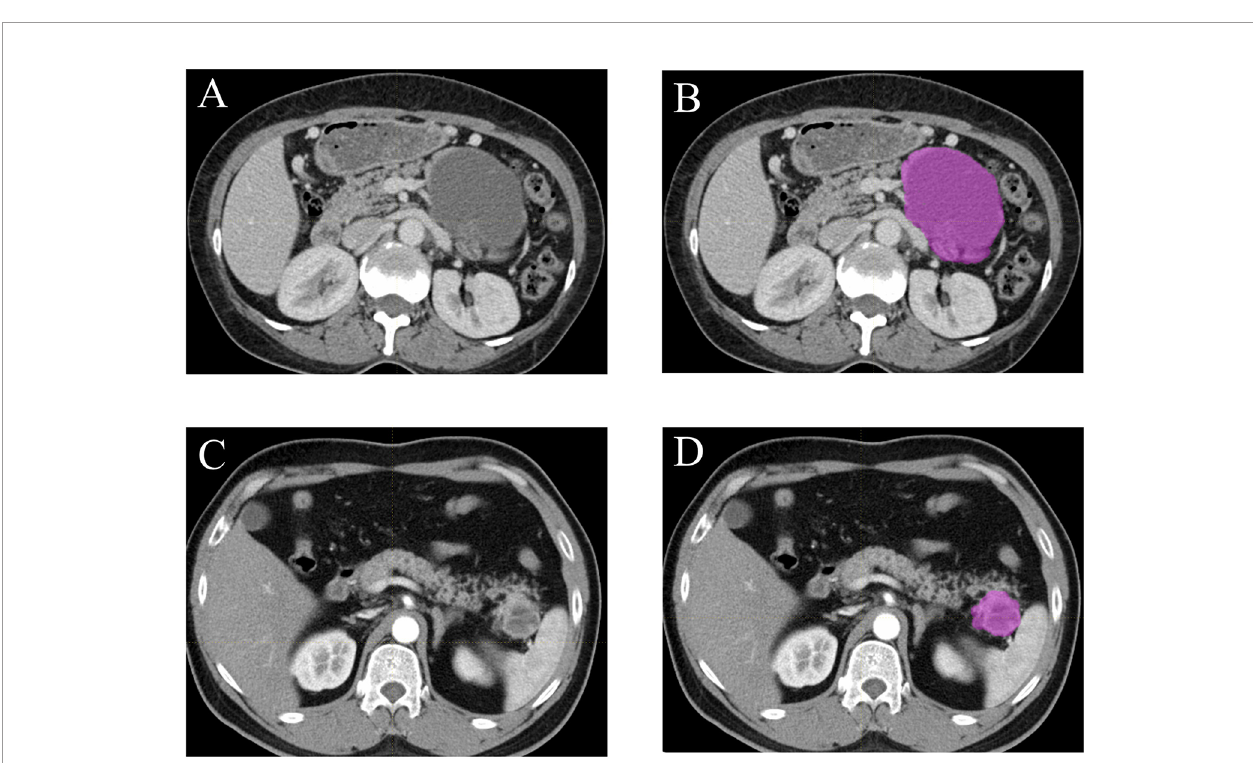
FIGURE 2 | Examples of lesion segmentation and contouring on contrast-enhanced CT images. Portal vein phase CT images of a patient with histopathologically proved pancreatic cystadenomas (A, B) and pancreatic neuroendocrine tumors (C, D)